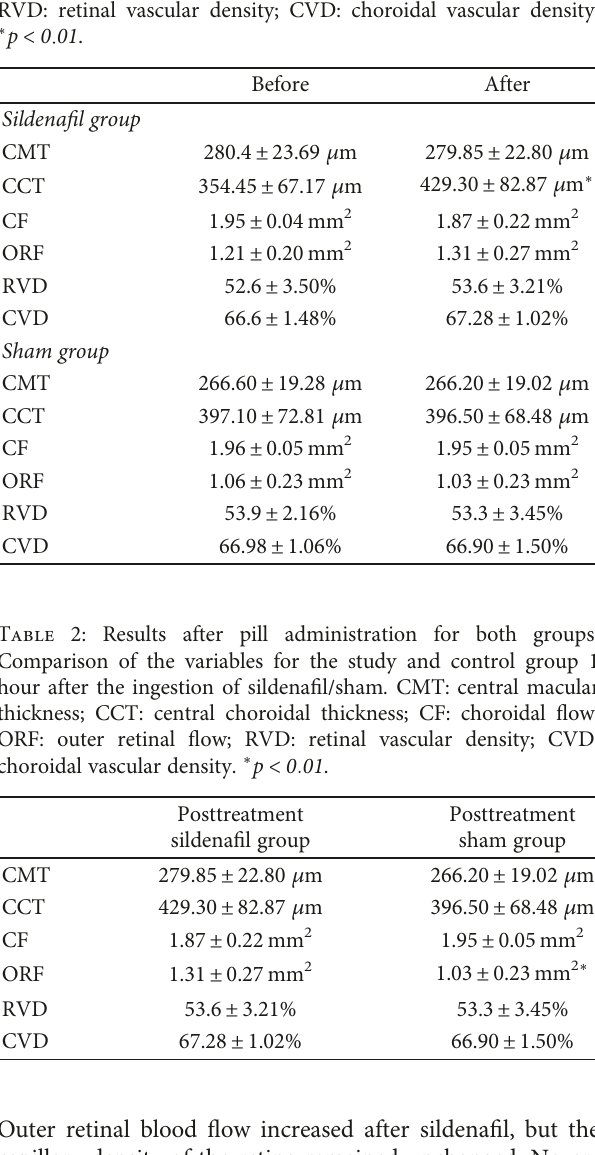
Table 1: Change in OCT before and after sildena fi l/sham. Comparison of variables before and after the ingestion of the pill for both groups. CMT: central macular thickness; CCT: central choroidal thickness; CF: choroidal fl ow; ORF: outer retinal fl ow;